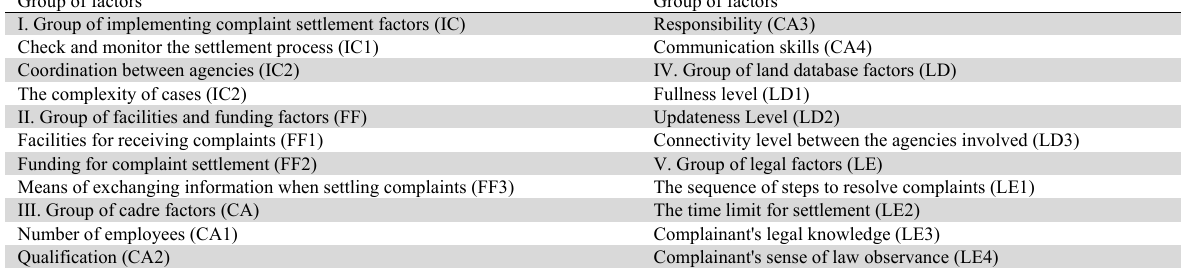
Groups of hypothetical factors affecting the settlement of complaints when the State acquires land in Bac Ninh city. Group of factors